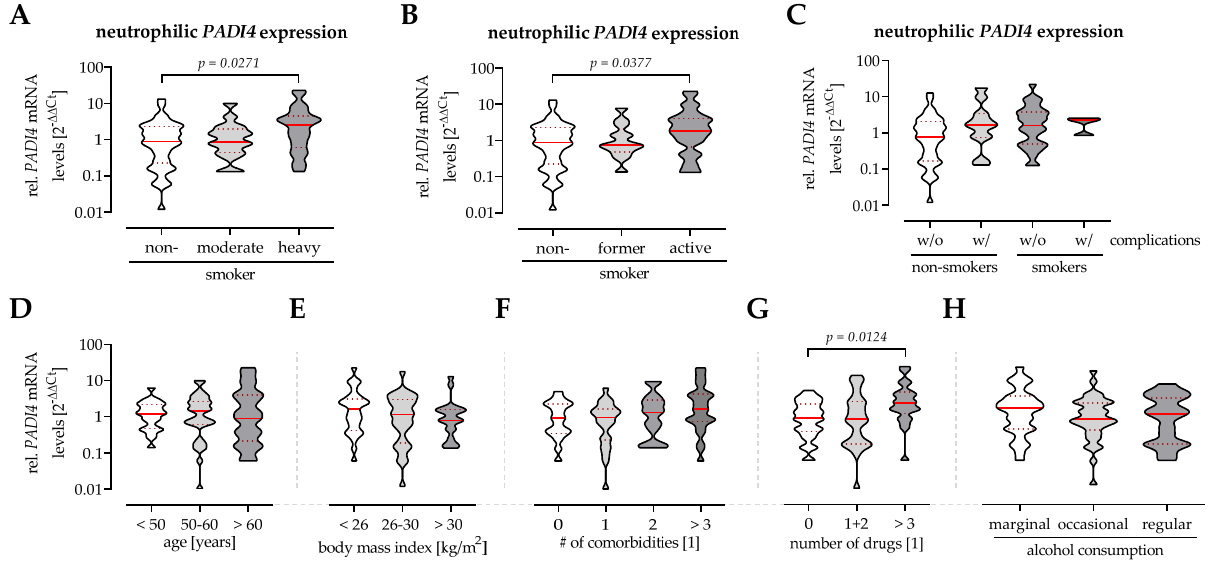
Figure 4. Influencing factors on neutrophilic PADI4 expression in orthopedic and trauma patients. Neutrophilic PADI4 expression was analyzed by qRT-PCR using the 2 − ∆∆ Ct method with EF1 α and RPL13a as housekeeping genes and non ‐ smokers as reference. To investigate the effect of smoking, samples were divided according to the patients smoking behavior, differentiating ( A ) non ‐ smokers (0 PY), moderate smokers (<20 PY), and heavy smokers ( ≥ 20 PY); ( B ) non ‐ smokers, former smokers and active smokers, and ( C ) non ‐ smokers and smokers that did or did not develop complications. To identify other factors that possibly affect neutrophilic PADI4 expression, samples were additionally grouped by ( D ) age, ( E ) body mass index, number of ( F ) comorbidities and ( G ) daily drugs, and ( H ) alcohol consumption. Data are presented as violin blots with median and interquartile range. Groups were compared by non ‐ parametric Kruskal–Wallis test followed by Bonferroni multiple comparison test. A p < 0.05 was considered as significant as is presented in the graphs.